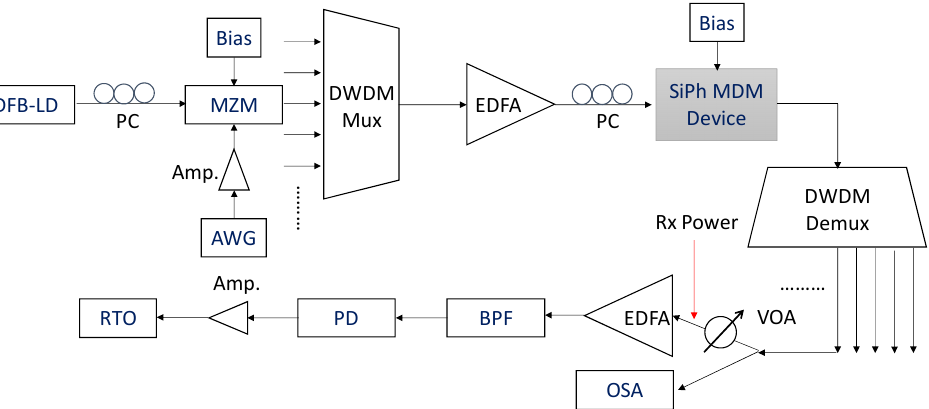
Figure 4. Experimental setup to evaluate the proposed switchable MDM optical power divider. AWG: